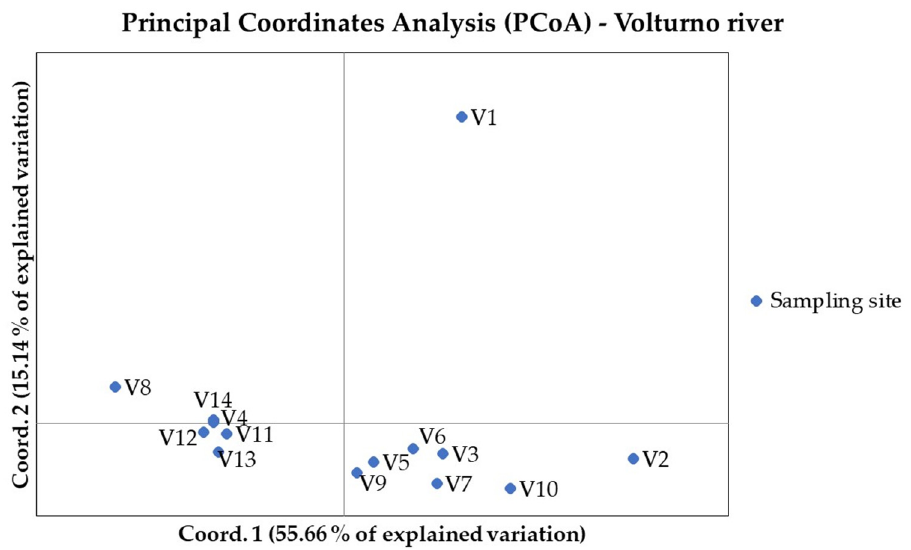
Figure 6. Principal coordinates analysis (PCoA) performed considering sampling sites in Volturno river. Sample locations and codes are detailed in Table S1.